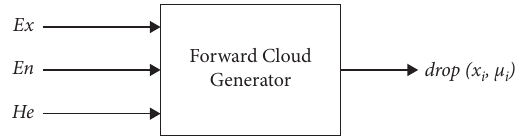
Figure 1: Forward cloud generator.